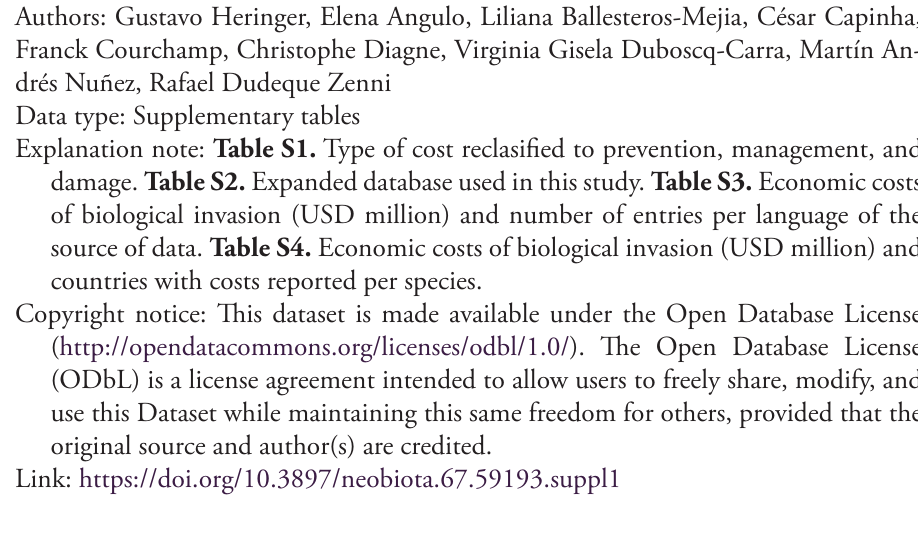
damage. Table S2. Expanded database used in this study. Table S3. Economic costs